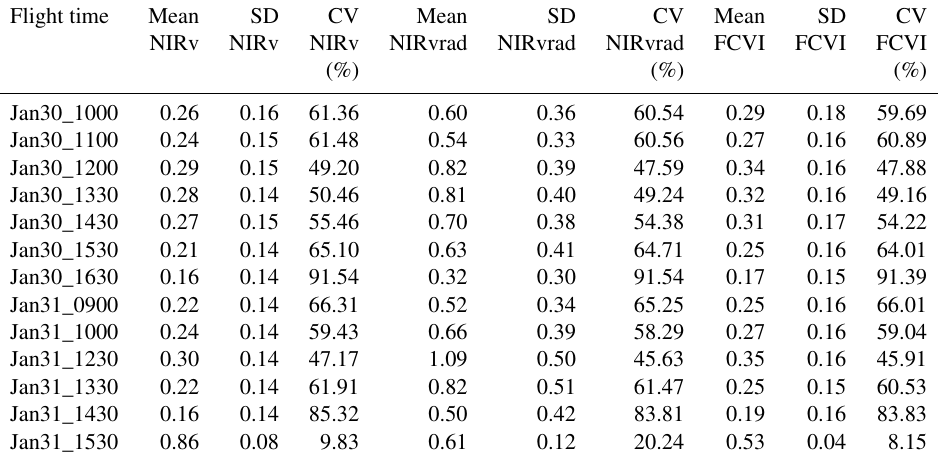
Table A1. Mean, standard deviation (SD), and coefficient of variation (CV) of NIRv, NIRvrad, and FCVI measurements for the study. Flight time